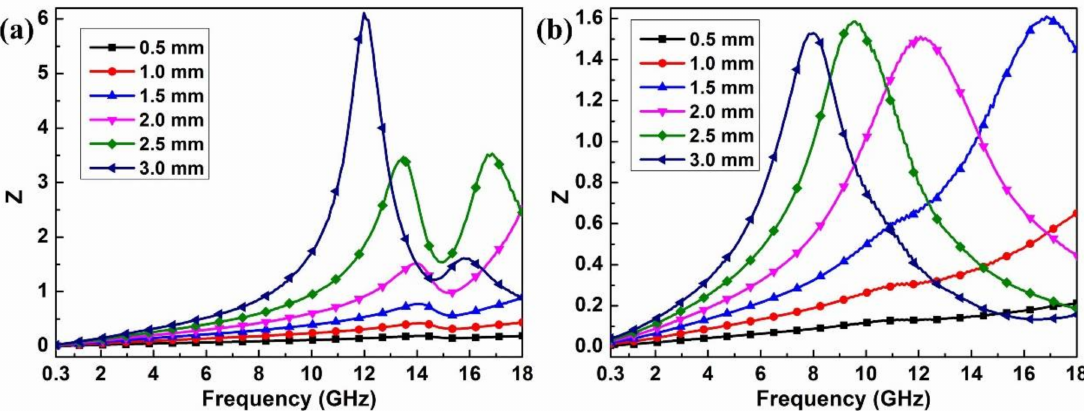
Figure 6. The modulus of normalized input impedance ( | Z in / Z 0 | ) : ( a ) Co 0.5 Ni 0.5 Fe 2 O 4 fibers; ( b ) Co 0.5 Ni 0.5 Fe 2 O 4